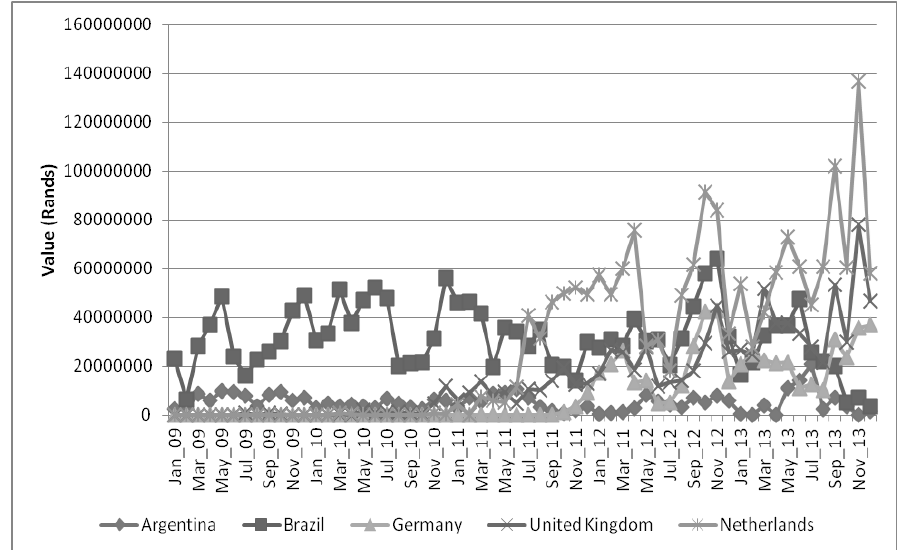
FIGURE 7: Trend in import structure of other bone-in portions across countries Source: Data from Quantec,